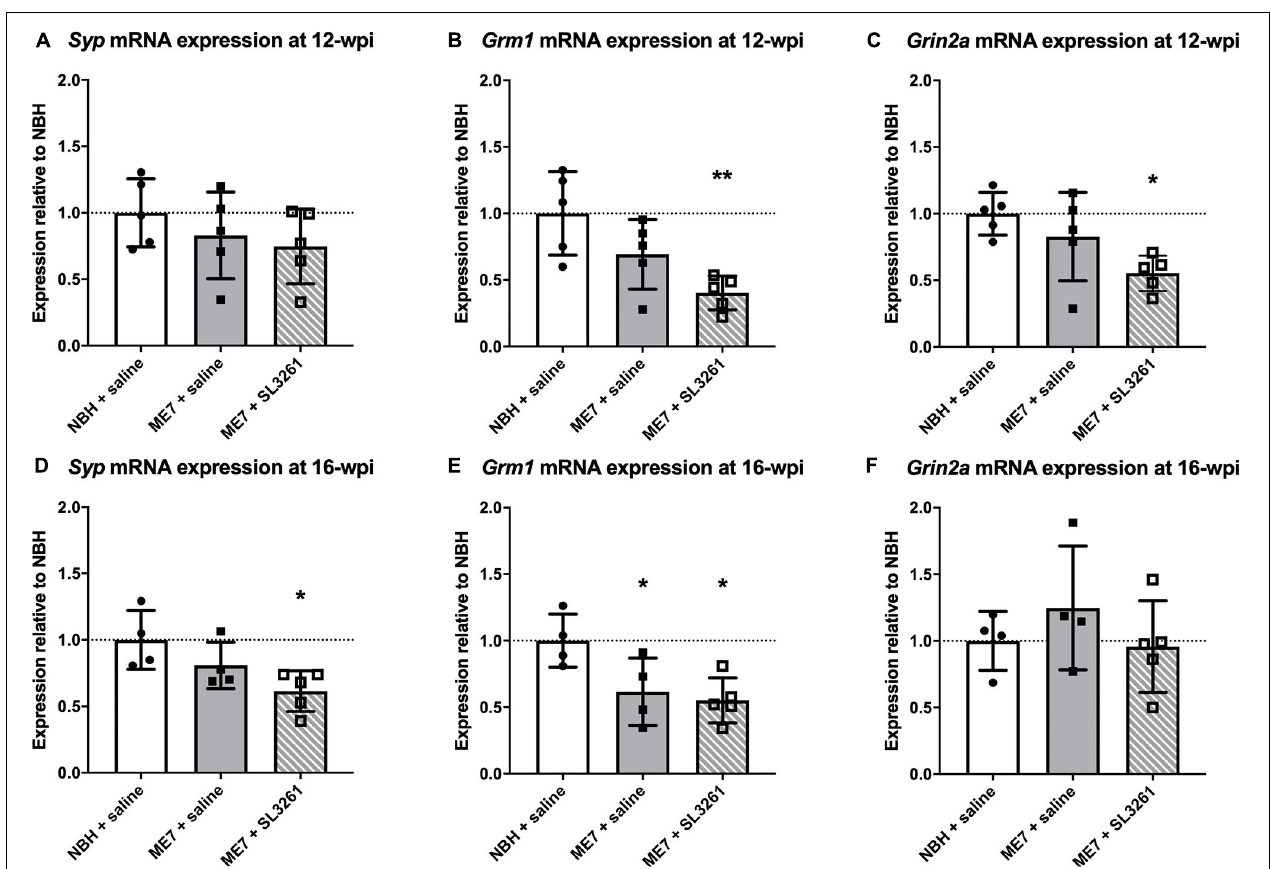
FIGURE 5 | Synapse marker gene transcription. The impact of systemic bacterial infection on synapse-associated gene transcription in ME7 prion mice at 12-wpi (A–C) and at 16-wpi (D–F) 4 weeks after treatment injection with saline or S. typhimurium SL3261 (1 × 10 6 cfu, i.p.) compared to NBH-injected control mice. (A) Syp mRNA expression is not reduced in ME7 prion mice at 12-wpi compared to NBH-injected control mice. Grm1 (B) and Grin2a (C) mRNA expression is significantly reduced following infection in ME7 prion mice compared to NBH-injected control mice. Syp (D) and Grm1 (E) mRNA expression is significantly reduced at in ME7 prion mice at 16-wpi following infection compared to NBH-injected control mice. Grin2a (F) mRNA expression at 16-wpi remains stable in ME7 prion mice, even after infection, compared to NBH-injected control mice. * p < 0.05; ** p < 0.01 vs. NBH + saline using one-way ANOVA with Holm-Sidak test for multiple comparisons; n =